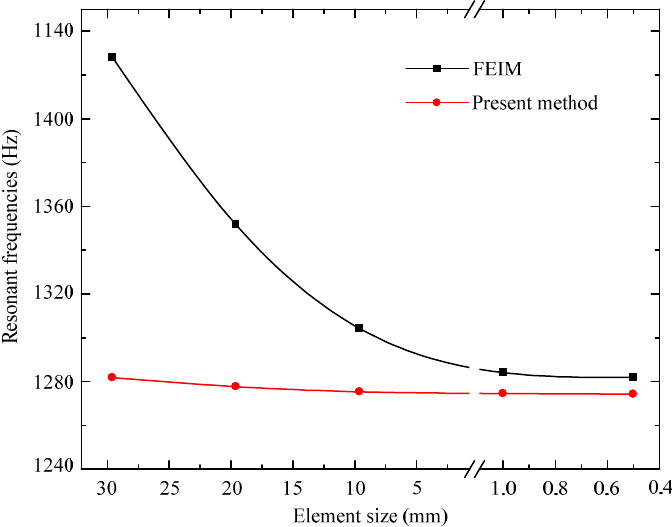
Figure 5. Convergences of nonlinear resonant frequencies of the finite element iteration method (FEIM) and present method under different element sizes.